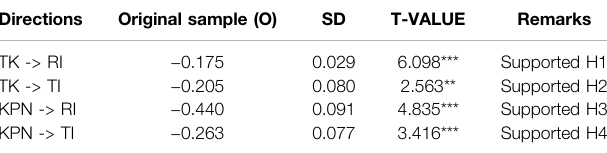
TABLE 5 | Direct relationship between the